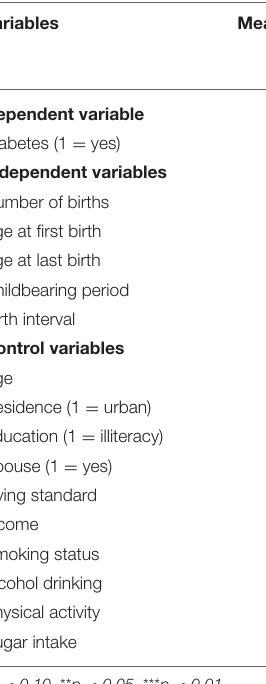
TABLE 1 | Descriptive